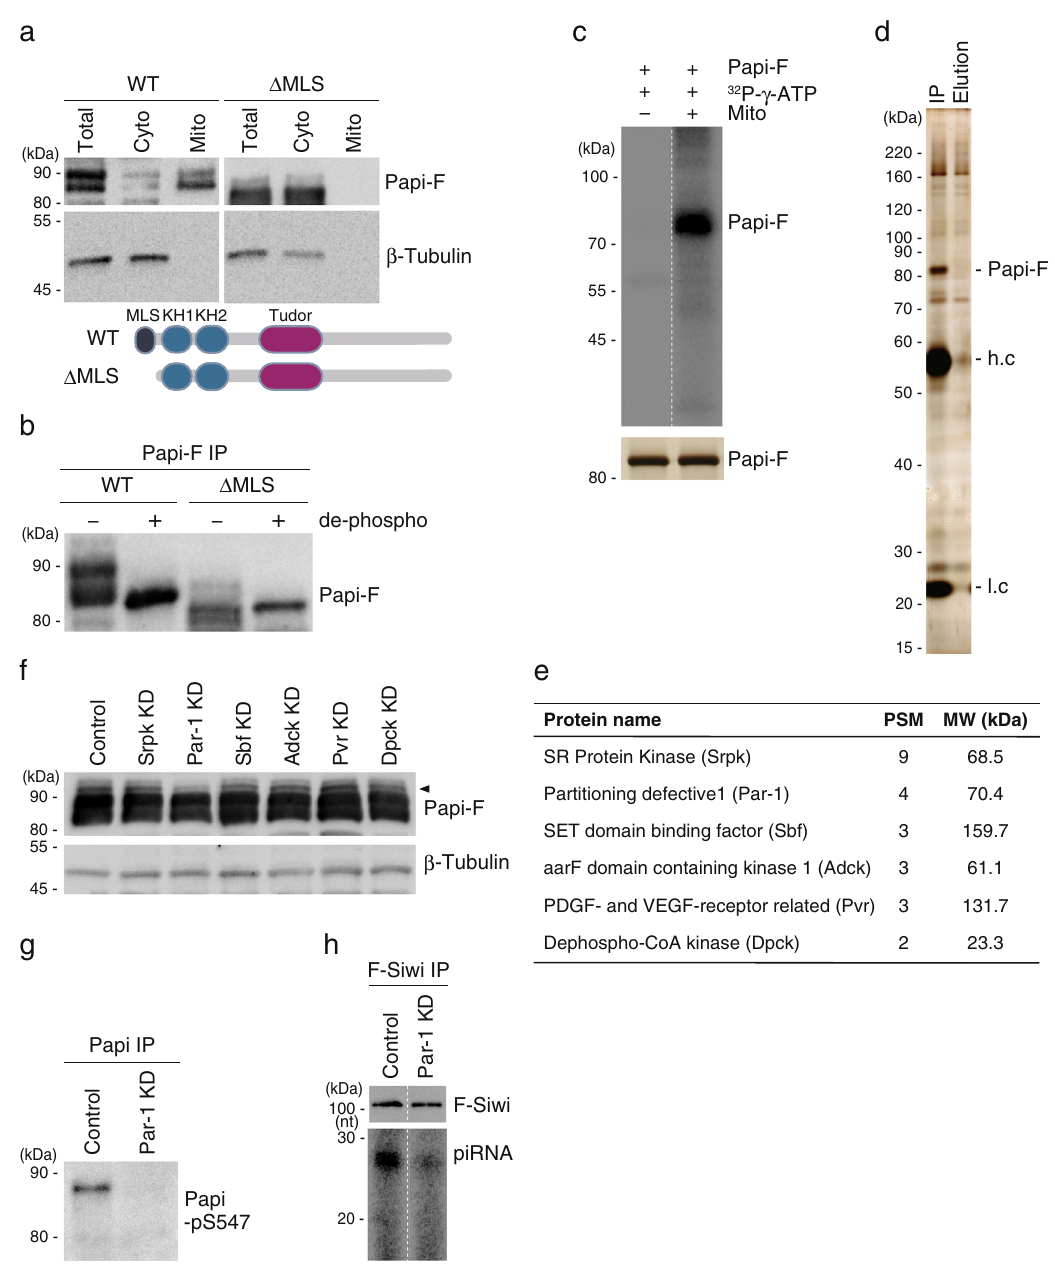
Fig. 2 Par-1 kinase is responsible for Papi Ser547 phosphorylation. a Western blotting shows that WT Papi is concentrated in the mitochondrial fraction (Mito), whereas the Papi Δ MLS mutant, which lacks the mitochondrial localization signal, is in the cytoplasmic fraction (Cyto) ( n = 3). Total, total lysates of BmN4 cells. β -Tubulin was used as a marker of the cytoplasmic fraction. The schematic drawing shows the domain structure of WT Papi and the Papi Δ MLS mutant. b Western blotting shows that WT Papi is ef fi ciently phosphorylated in vivo, whereas the Papi Δ MLS mutant is not ( n = 3). de-phospho, the immunoprecipitated materials were treated with ( + ) and without ( − ) phosphatase prior to western blotting. c Papi-Flag (Papi-F) (upper) was 32 P-labeled ef fi ciently upon incubation with the mitochondrial fraction (Mito) of BmN4 cells in the presence of 32 P- γ -ATP. Silver-stained Papi-F (lower) used in the assay is shown ( n = 3). d Silver staining shows proteins that co-immunoprecipitated with Papi-F after incubation with the mitochondrial fraction of BmN4 cells. IP, proteins co-immunoprecipitated with Papi-F; Elution, proteins bound to Papi-F were eluted with high-salt buffer; h.c., heavy chain of the antibody; l.c., light chain of the antibody ( n = 3). e Six kinases identi fi ed in the mass spectrometric analysis. PSM, peptide-spectrum match; MW, predicted molecular weight. f The six kinases in ( e ) were depleted by RNAi (KD) in BmN4 cells, and the levels of Papi-F within the cells were examined by western blotting ( n = 3). The RNAi ef fi ciency was examined by RT-qPCR (Supplementary Fig. 2c). β -Tubulin was used as a loading control. g Papi-pSer547 was detected before Par-1 depletion (Control) but not after Par-1 depletion (Par-1 KD) ( n = 3). Anti-Papi-pSer547 antibody (Supplementary Fig. 2d, e) was used. h Siwi- piRISC was barely detected in Par-1-depleted cells (Par-1 KD) ( n = 3). F-Siwi, Flag-Siwi. piRNAs were visualized by 32 P-labeling. Source data are provided as a Source Data fi